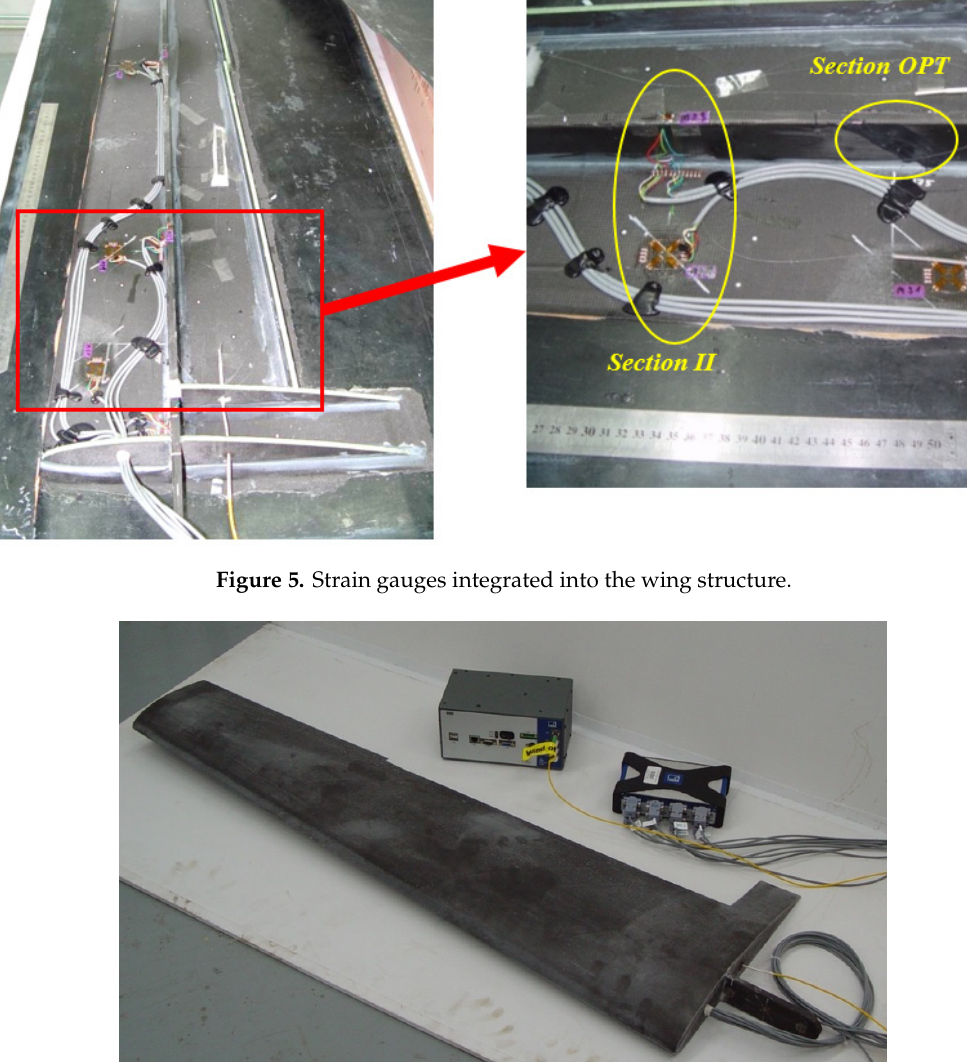
Figure 6. Complete tested wing and acquisition systems.